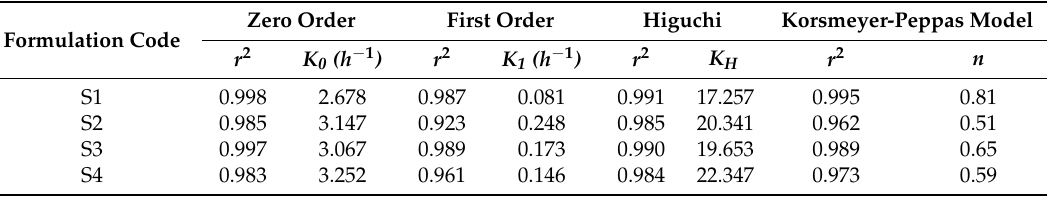
Table 3. Release kinetics data treatment for proniosomal gel formulations.